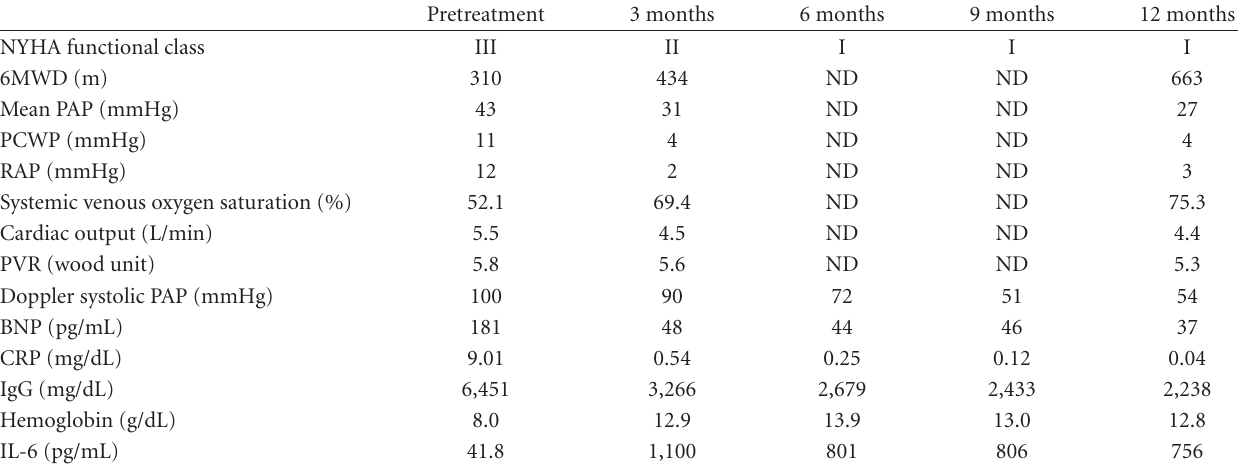
Table 1: Serial functional, hemodynamic, and laboratory parameters before and after the tocilizumab treatment.